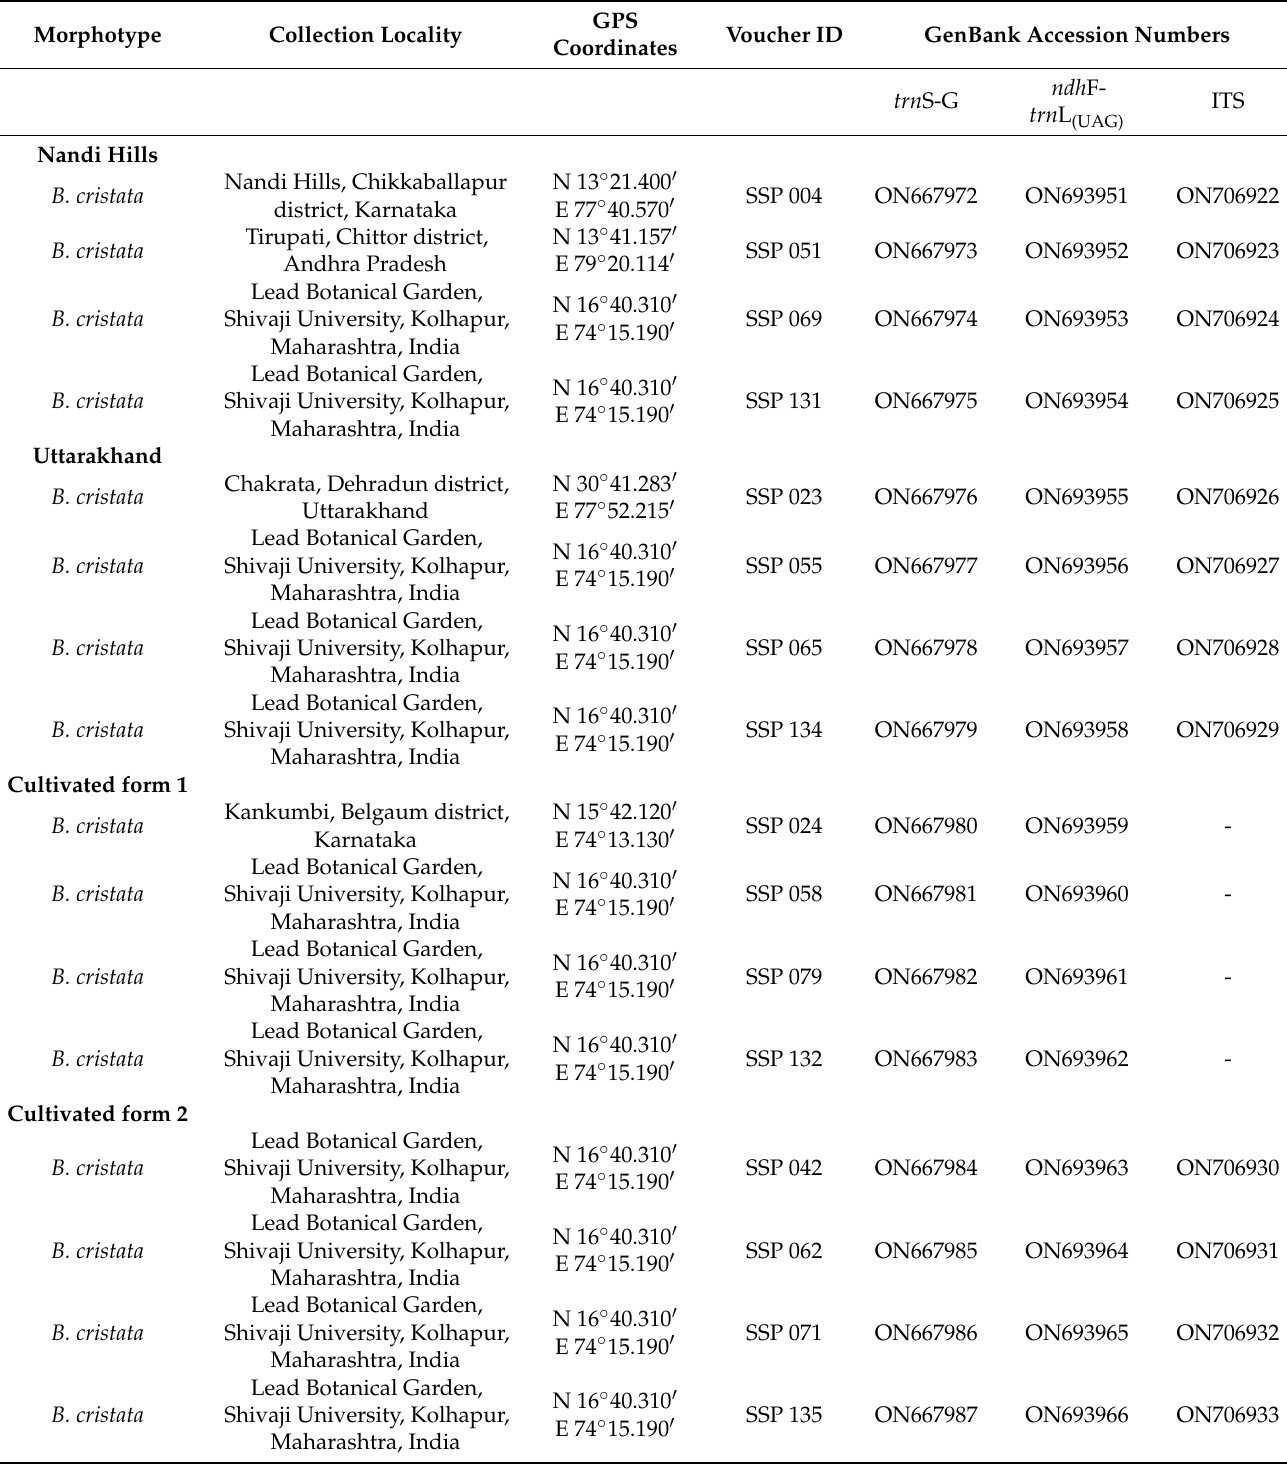
Table 1. Details of Barleria cristata morphotypes (collection locality, GPS coordinates, vouchers and GenBank accession numbers for trn S-G, ndh F- trn L (UAG) and ITS